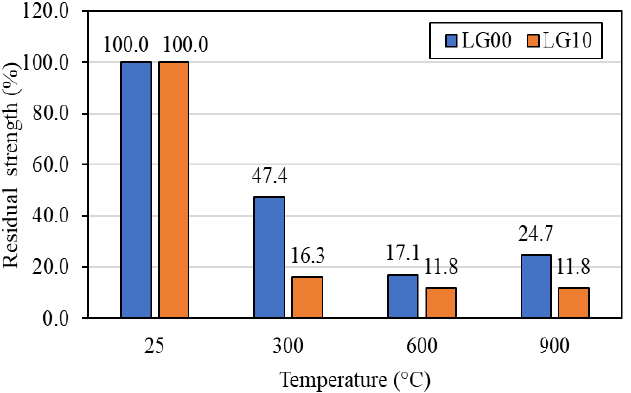
Figure 18. Residual compressive strength of LG00 and LG10 after exposure to elevated tempera-